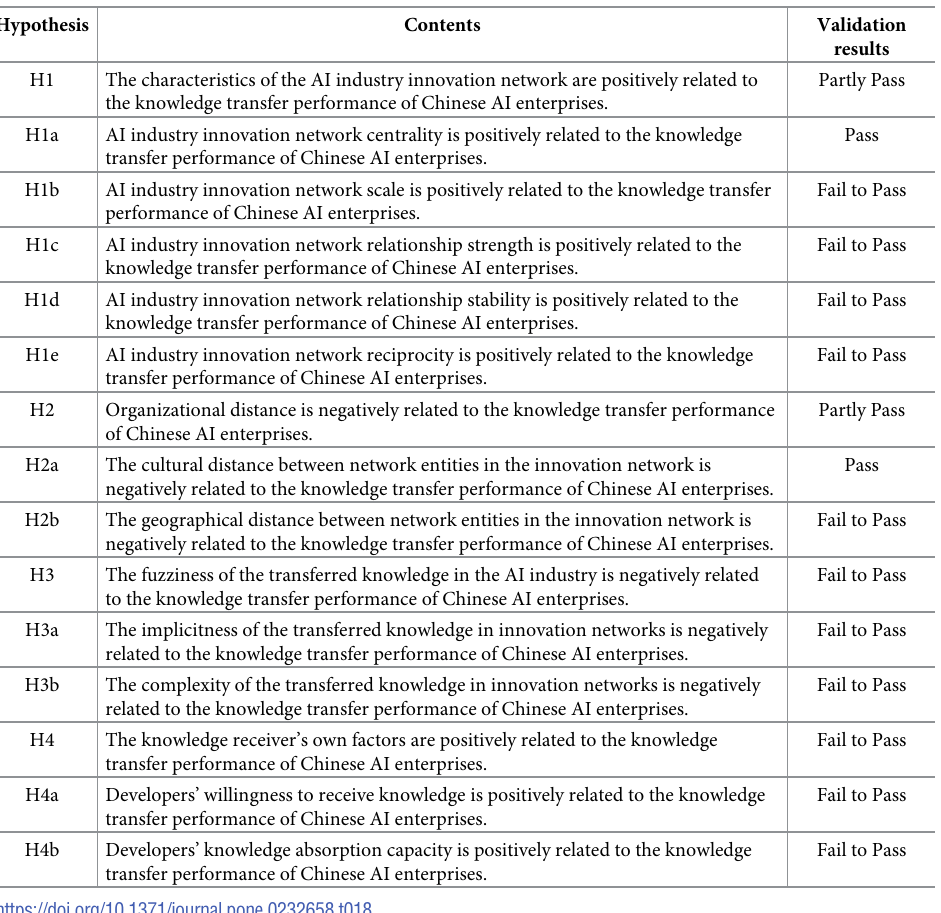
Table 18. Stepwise regression analysis